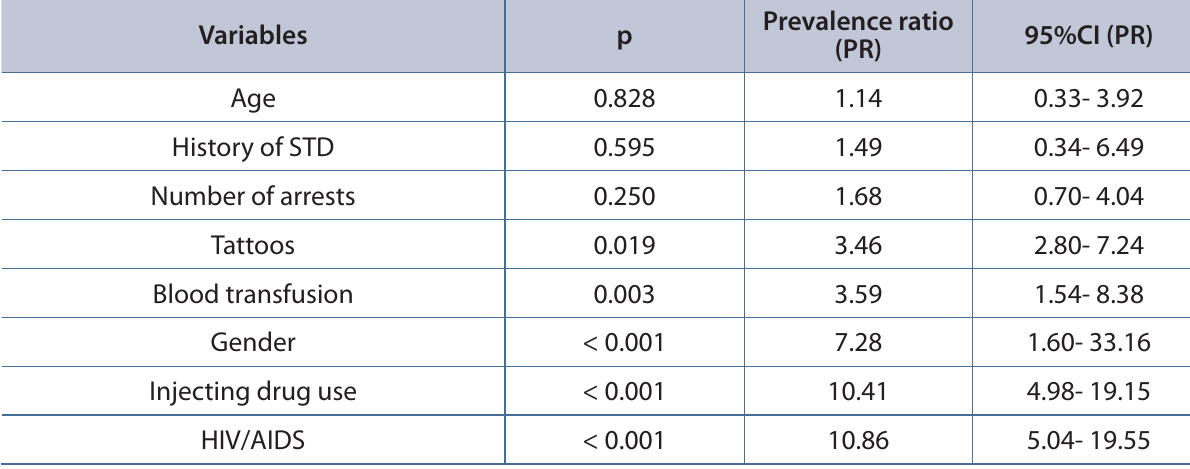
Table 3. Variables analyzed by multivariate analysis on the prevalence of HCV among inmates in Campo Grande, Mato Grosso do Sul, Brazil in